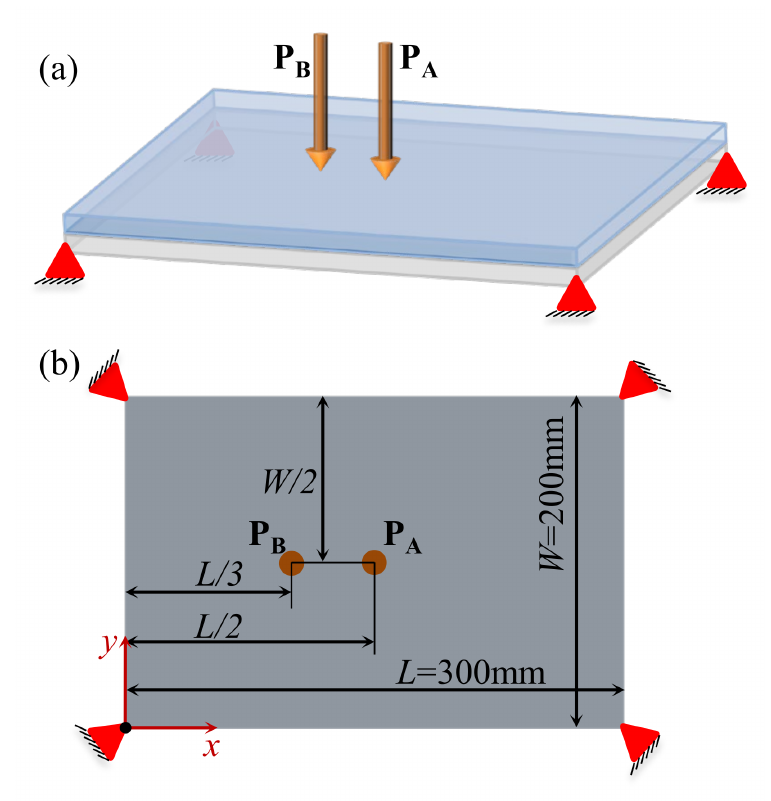
Figure 19. A rectangular plate clamped with four corners. ( a ) Three-dimensional view. ( b ) Top view of the plate.